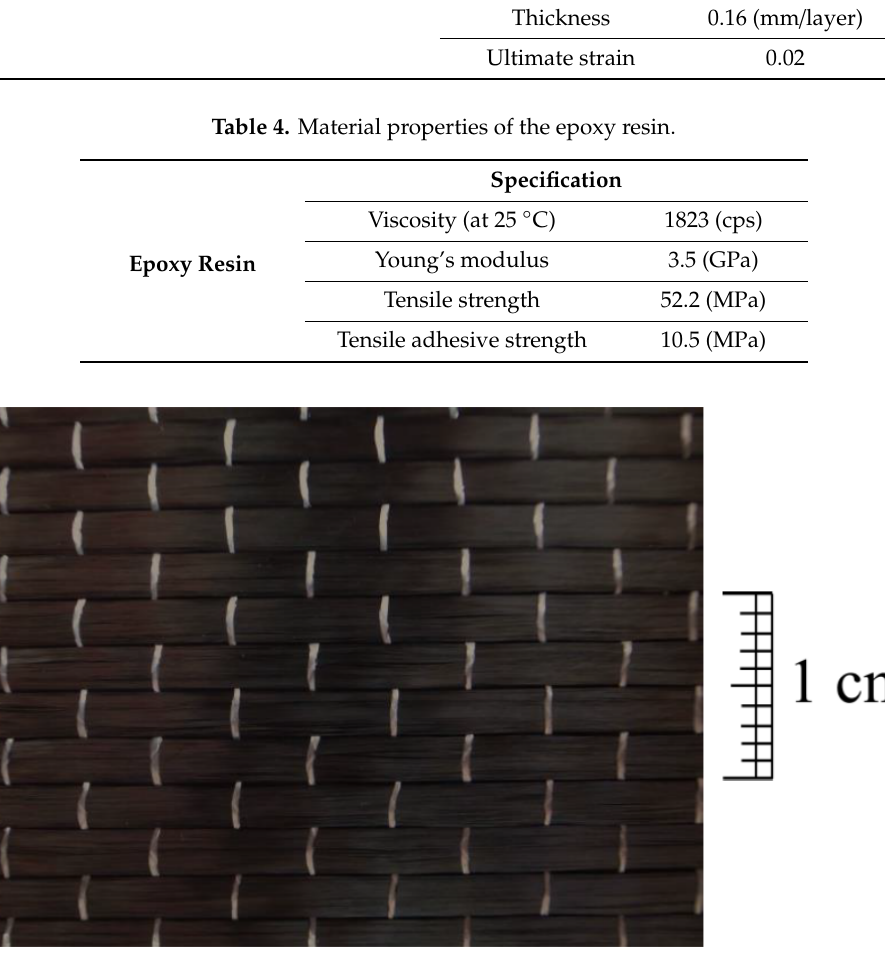
Table 3. Material properties of the uni-directional carbon fiber sheet (12 k, FAW = 300 g/m 2 ).